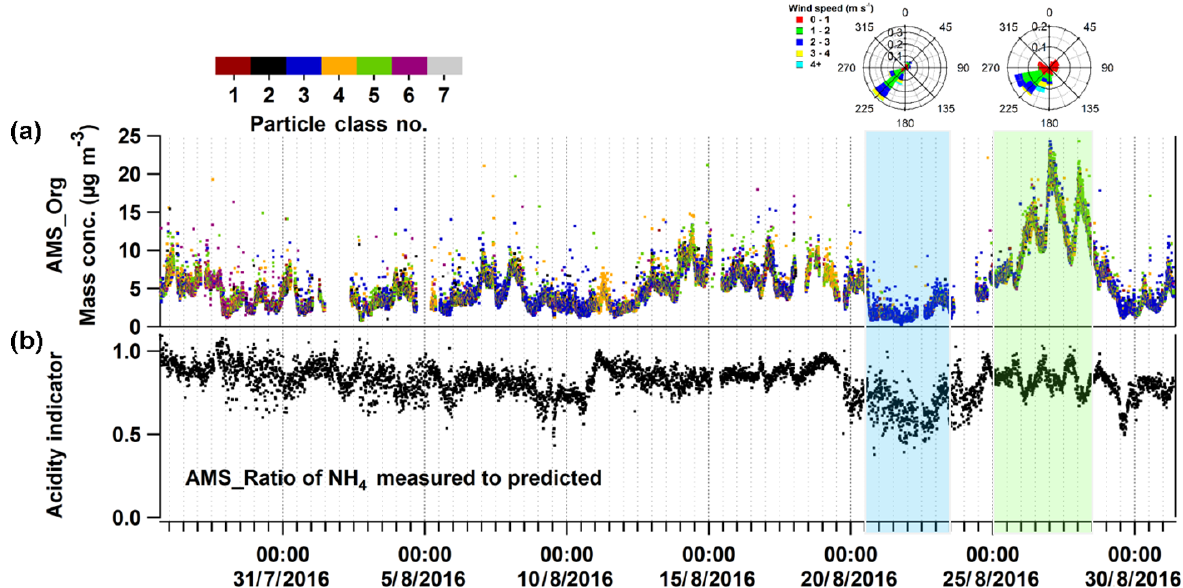
Figure 3. Time series of particulate organic mass measured by the AMS (AMS org in panel a ), the particle acidity indicator (the lower the value the more acidic, b ), and the particle class number classified by LAAPTOF (colour code, a ). The seven classes are as follows. Class 1: calcium–soil; class 2: aged soot; class 3: sodium salts; class 4: secondary inorganics–amine; class 5: biomass burning–soil; class 6: biomass burning organosulfate; and class 7: mixed/aged dust. The first (blue) and second (green) shaded areas mark the sodium-chloride-rich and organic-rich episodes.